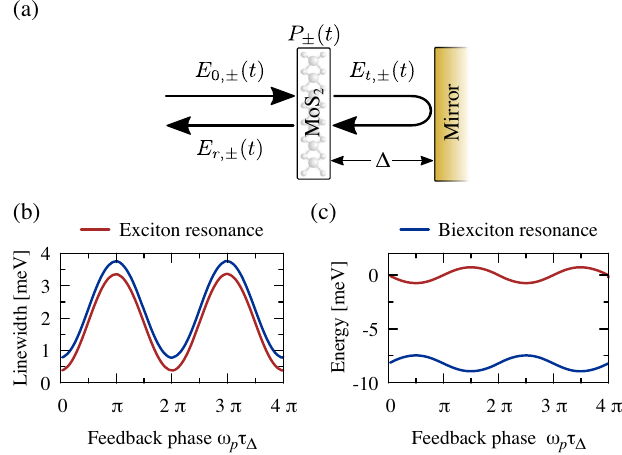
FIG. 8. (a) Illustration of a closed loop with a mirror placed in a distance Δ from the two-dimensional semiconductor. The in- t Þ drives the exciton transitions P coming light field E 0 ; (cid:3) ð E 0 t Þ and P ð t Þ determine the transmitted E t; ; (cid:3) ð (cid:3) t Þ light fields. (b),(c) Feedback phase ω E r; (cid:3) ð (b) linewidths and (c) resonance energies for exciton and biexciton resonances in a monolayer of MoS 2 at 5 K for excitation with low pulse areas Θ → 0